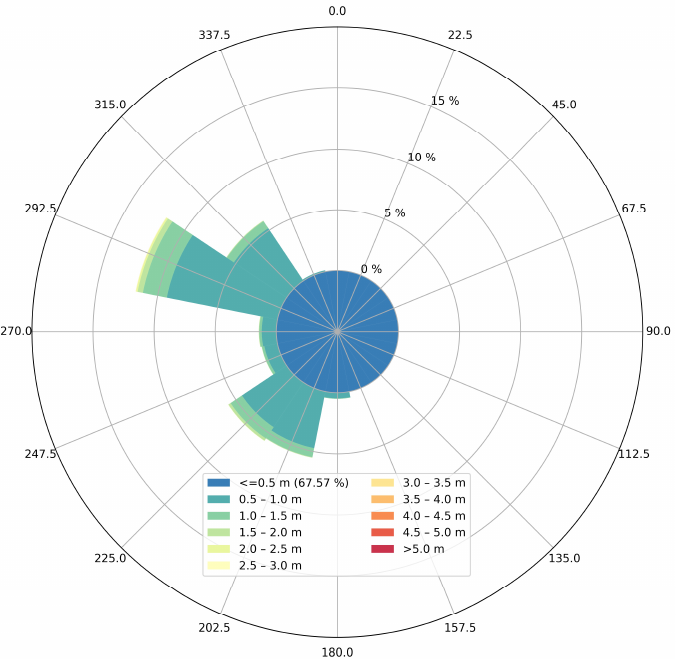
Figure 2. Wave rose plot of the mean annual wave climate for the idealized test case. Table 3. Classification for the BSS (Adapted with permission from Ref [45], 2004, Elsevier).